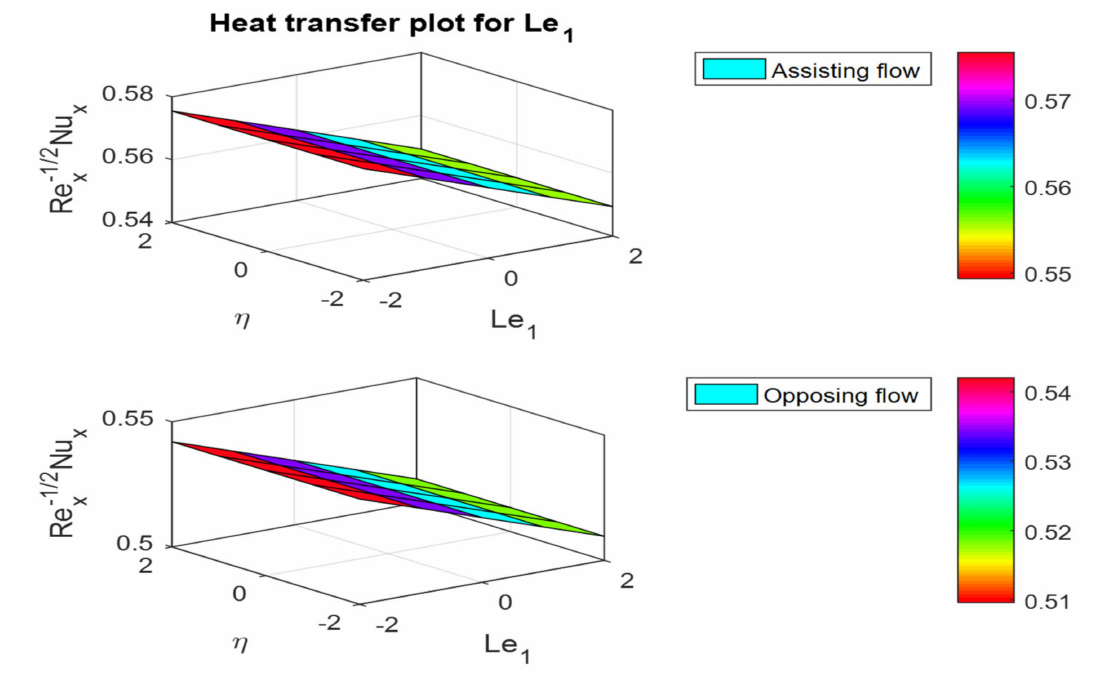
Figure 38. Surface plots for the θ (cid:48) ( 0 ) for dissimilar values of Le 1 .